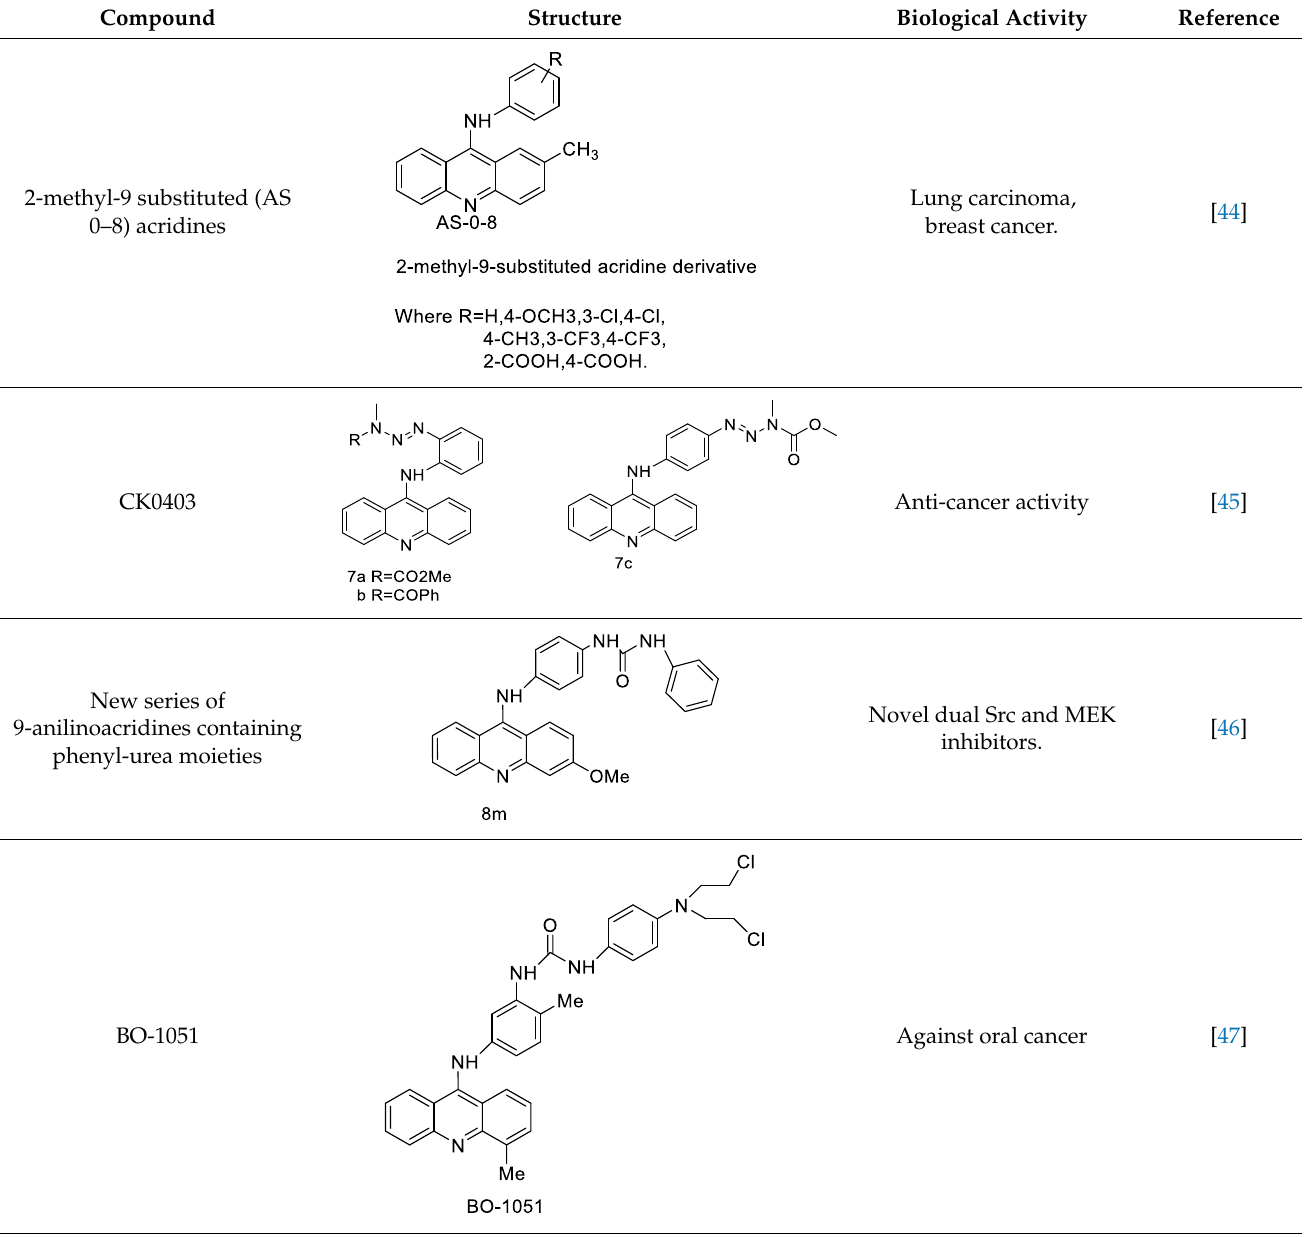
Table 3. 9-anilinoacridine as an anti-tumour agent.